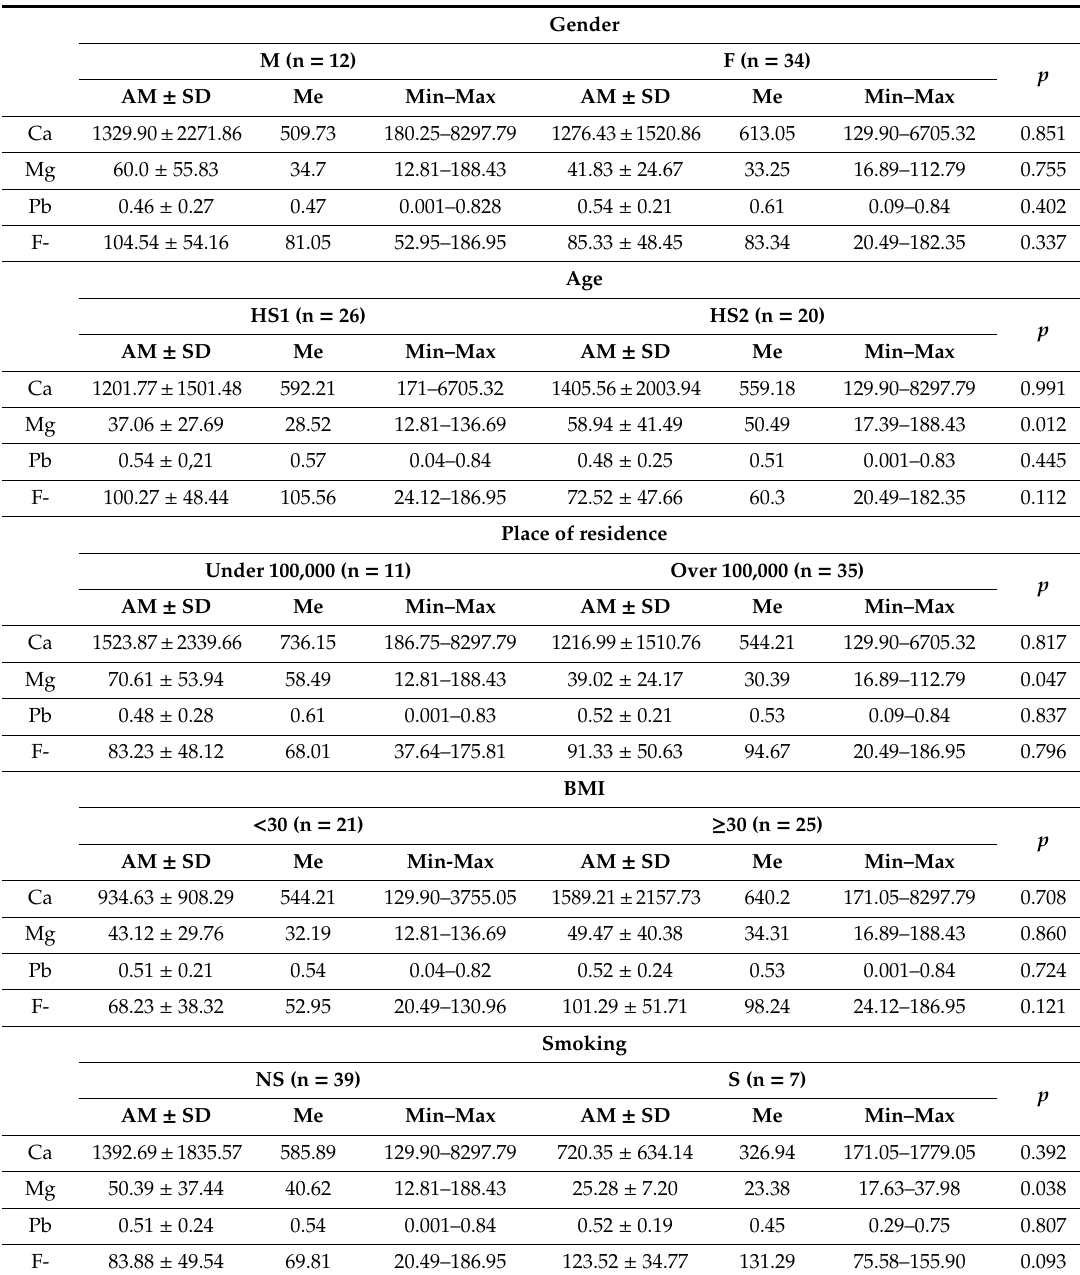
Table 2. Concentration levels of Ca, Mg, F-, Pb in the infrapatellar fat pad and their relation to selected biological and environmental